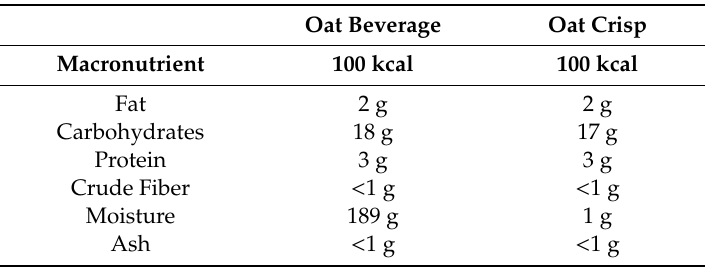
Table 1. Macronutrient composition of oat